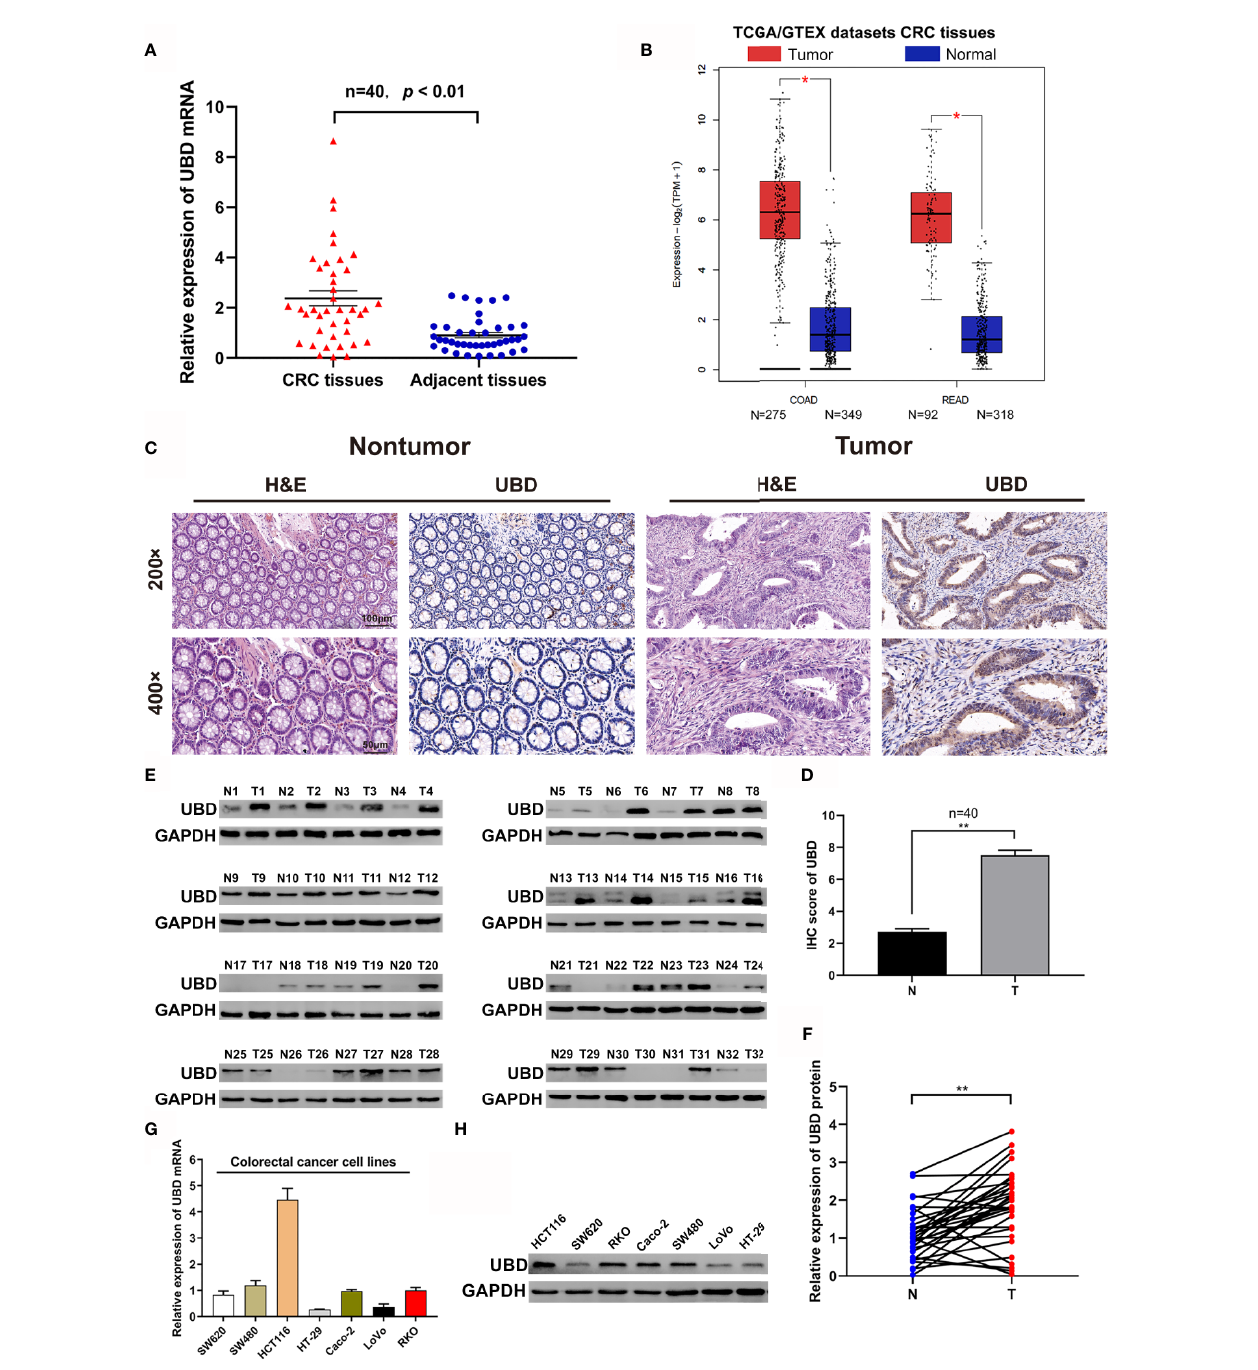
FIGURE 1 | The expression of UBD in CRC. (A, B) The expression level of UBD was detected in 40 cases of CRC tissue samples (A) and the TCGA/GTEX datasets (B) . (C) H&E staining was used to detect the benign and malignant tissues, IHC staining of UBD was used to determine the expression of UBD protein in CRC tumor tissues and adjacent nontumor tissues (magni fi cations, 200× and 400×; scale bar, 100 m m and 50 m m). (D) IHC score of UBD in CRC tumor tissues (T) and adjacent nontumor tissues (N) (n = 40, ** p < 0.01). (E) Western blot analysis of UBD protein expression from CRC tissues, GAPDH was used as a loading control. (F) Relative expression of UBD protein was quantized by analyzing grayscale value of Western blotting bands in 32 pairs of CRC tissues. (n=32, ** p < 0.01). (G, H) Relative mRNA level (G) and protein level (H) of UBD in seven CRC cell lines including SW620, SW480, HCT116, HT-29, Caco-2, LoVo and RKO. GAPDH was used as a loading control. CRC, colorectal cancer; COAD, Colon adenocarcinoma; READ, Rectal adenocarcinoma; H&E, hematoxylin and eosin; IHC, immunohistochemistry; UBD, Ubiquitin D; GAPDH, glyceraldehyde 3 ‐ phosphate